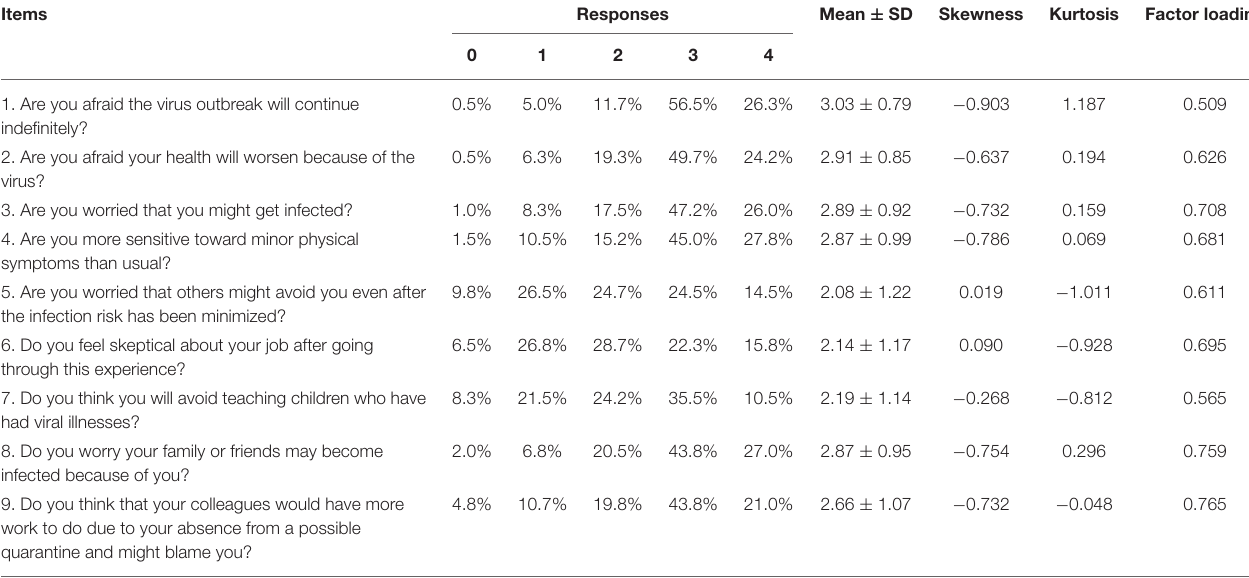
TABLE 2 | Factor structure of the schoolteachers’ version of the SAVE-9 scale and factor loadings.